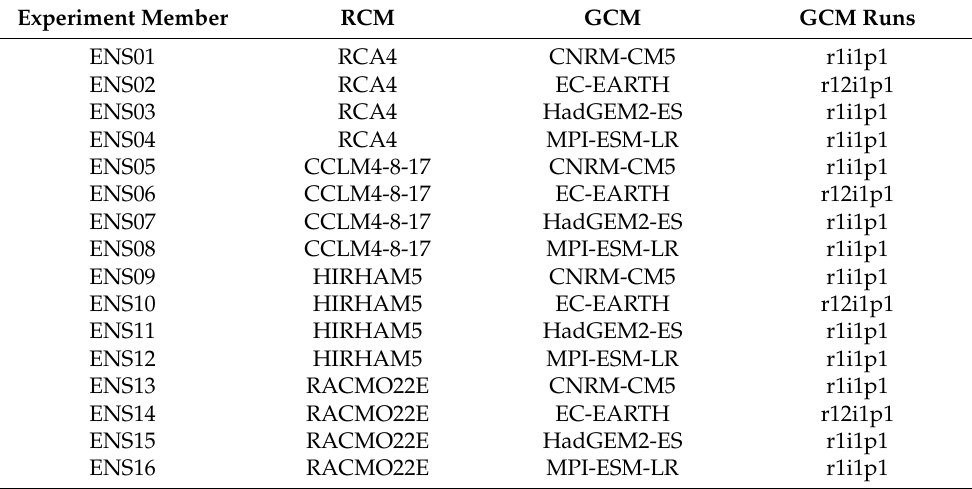
Table 1. Ensemble members used in this